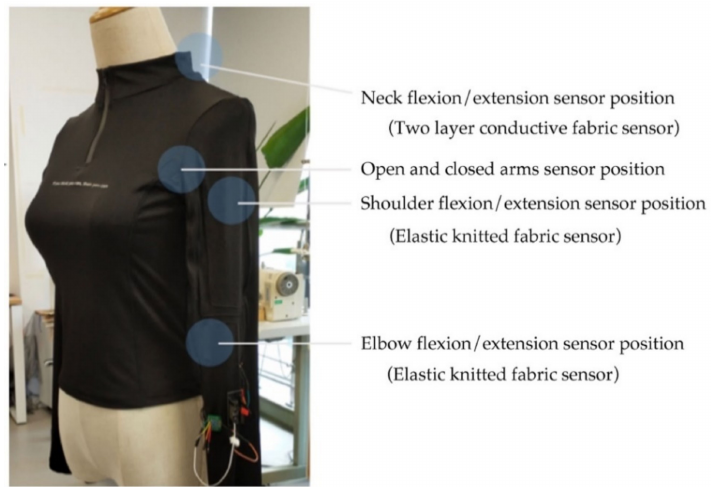
Figure 4. The female version of the E-MotionWear prototype and placement of the different